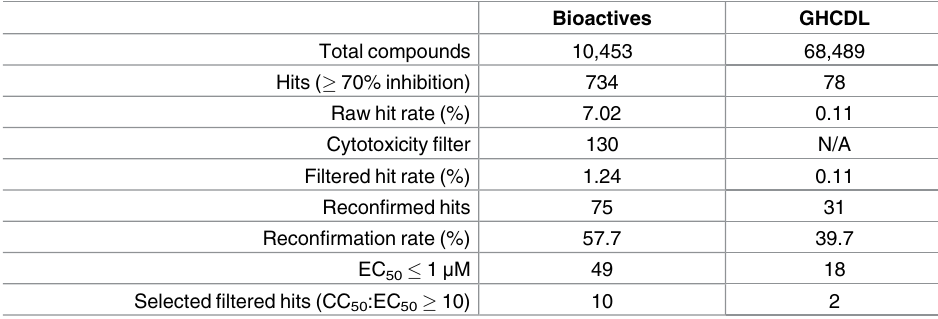
Table 1. Screening results, including compound totals for each